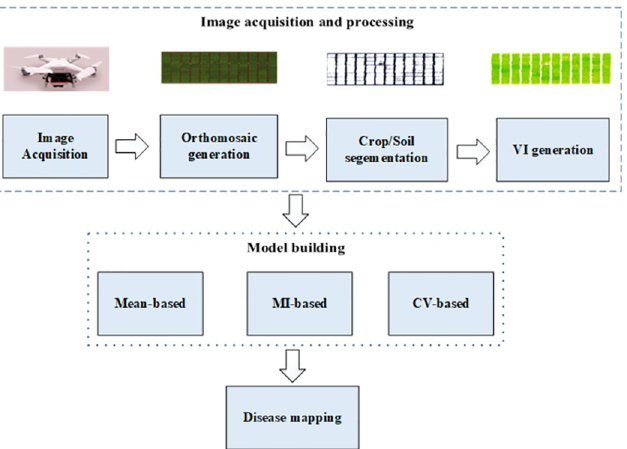
Fig 13. A high-level flowchart of proposed cooperative scheme for automatic disease estimation using UAV multispectral